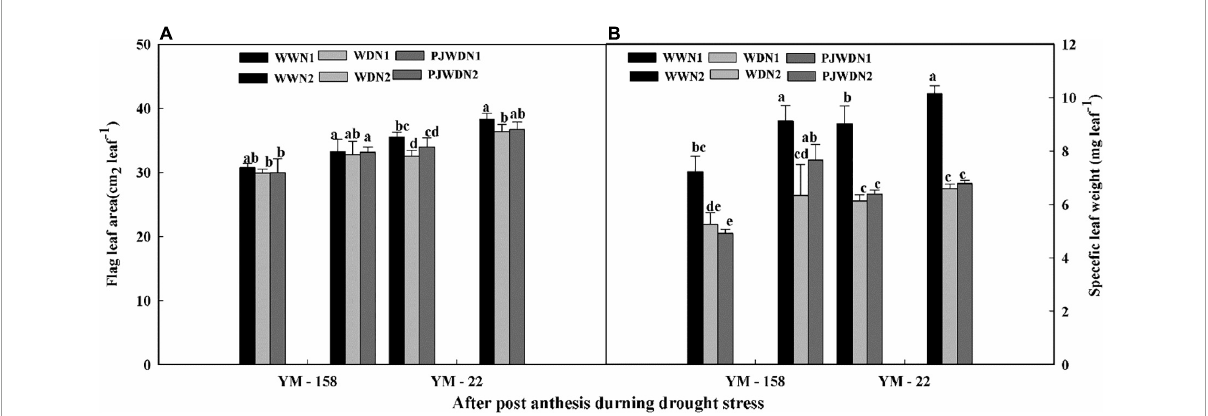
FIGURE8 Effects of pre-drought priming on flag leaf area and specific leaf weight in response to post-anthesis drought stress under two nitrogen (N) rates (N1, 180 and N2, 300) in Yangmai-158 and Yangmai-22 (A) , and Yangmai-158 and Yangmai-22 (B) wheat cultivars. Treatments: WW, (control) no priming at jointing + no post-anthesis drought stress; PJWD, priming at jointing + post-anthesis drought stress; and WD, no priming at jointing + post-anthesis drought stress. Pre-drought priming was completed during the jointing stage, and post-anthesis drought stress was applied from 7 to 14 days after anthesis. Each vertical bar above the mean value indicates the standard error of three replicates ( n = 3) by using three-way ANOVA at P <